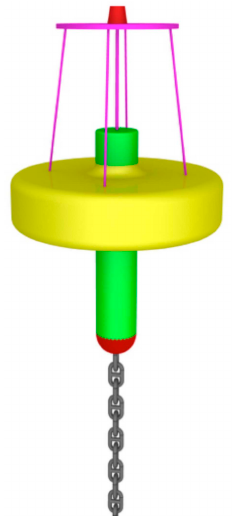
Figure 7. Graphical representation of the DEIM Point Absorber.